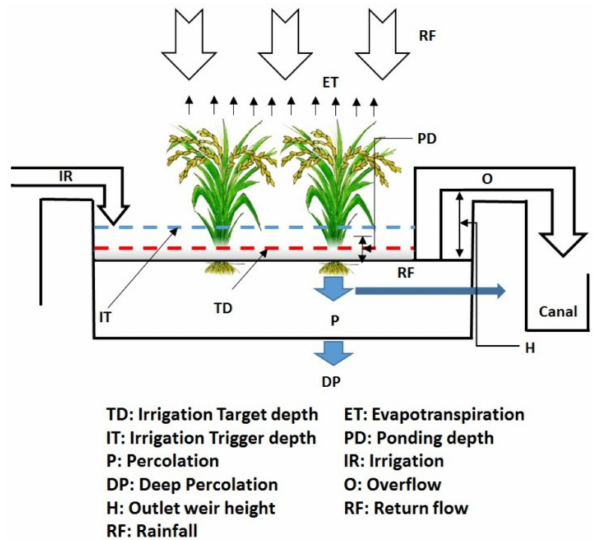
Figure 2. Paddy water budget in Agricultural Policy / Environmental eXtender (APEX)-Paddy